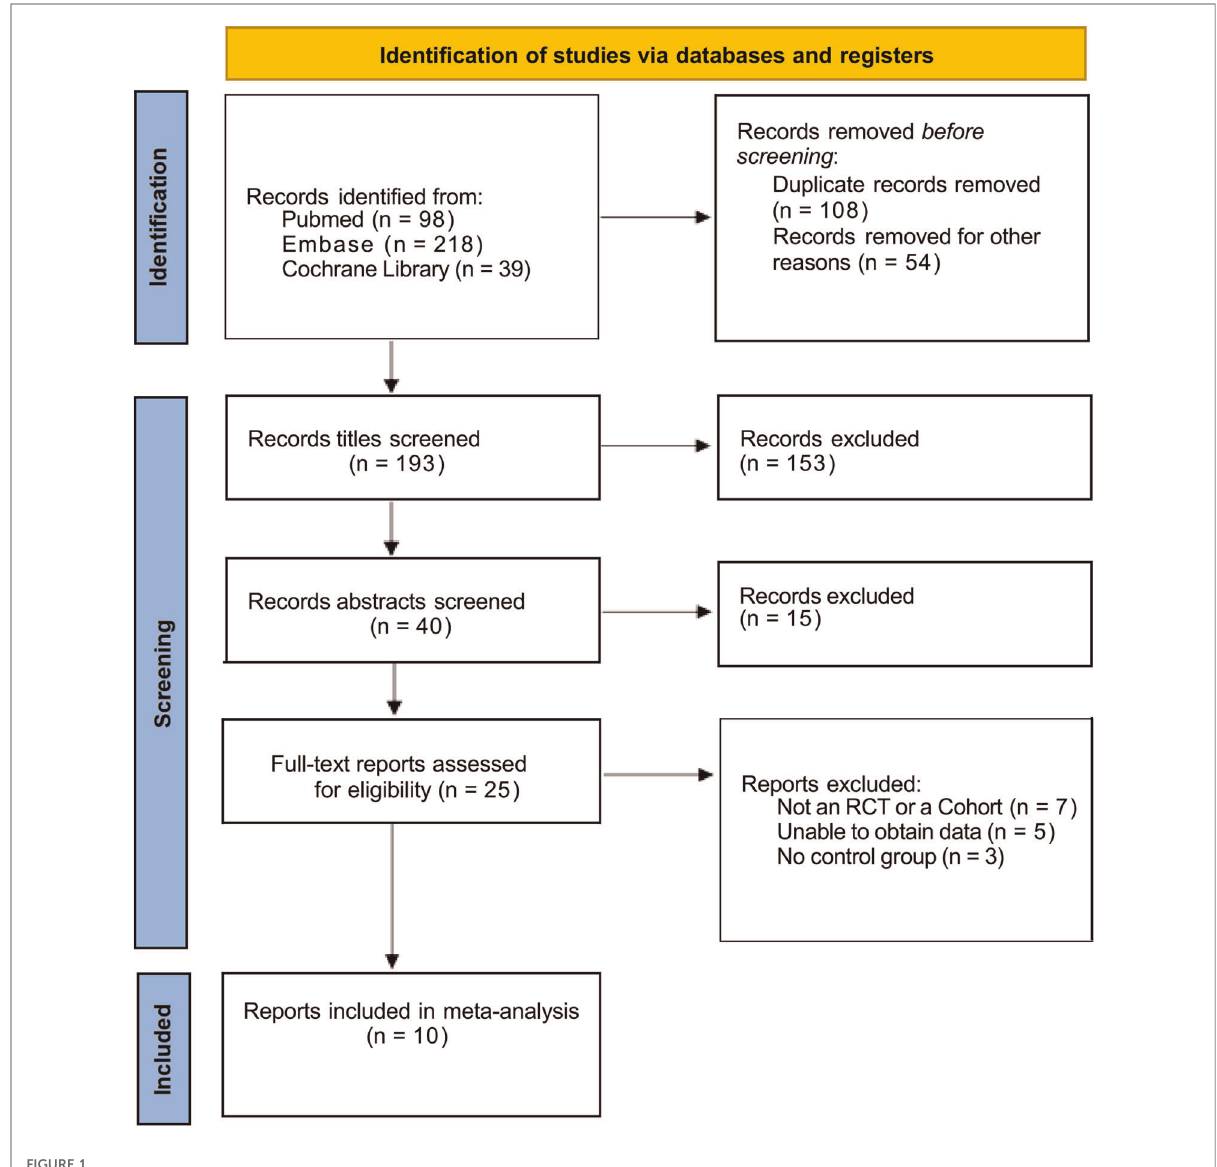
FIGURE 1 Flow chart of literature